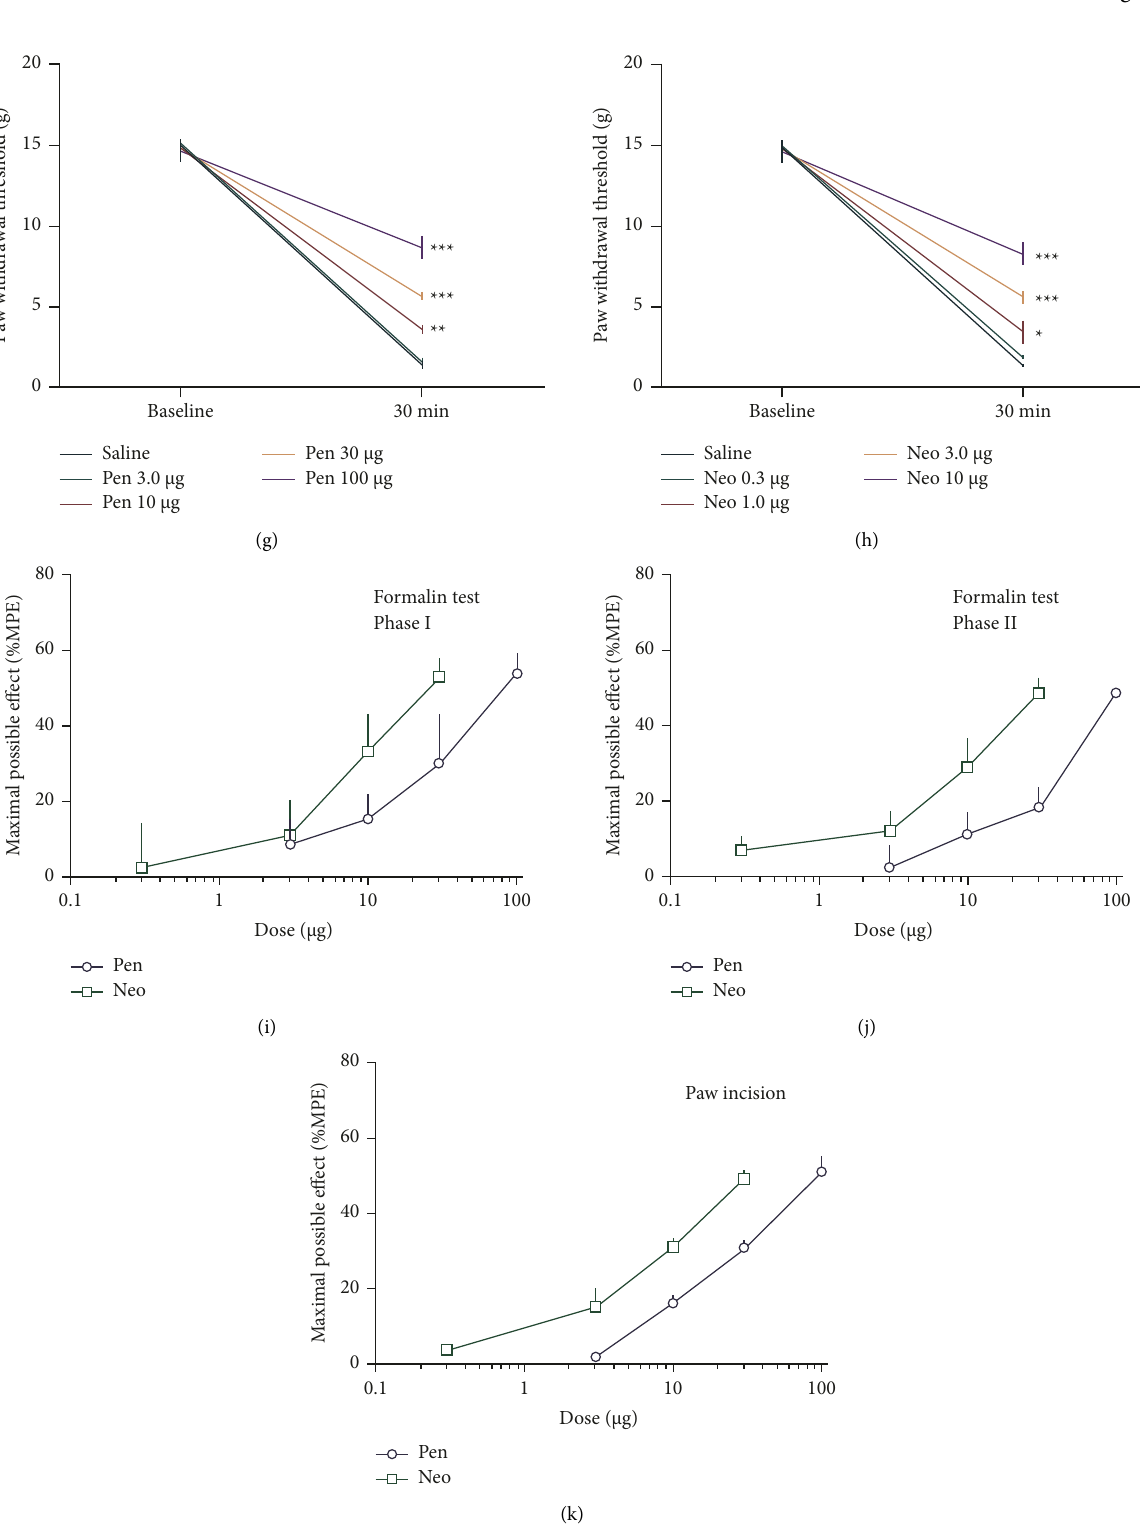
Figure 2: (a-f). Intrathecal injection of pentazocine (3–100 μ g) and neostigmine (0.3–10 μ g) induced a dose-dependent inhibition against the formalin-induced pain responses in both phases. (g-h). Injecting pentazocine or neostigmine attenuated the plantar incision-induced mechanical allodynia. (i-k). Dose-response curves of intrathecal pentazocine and neostigmine for flinching during phase I (i) and phase II (j) in the formalin test (k). Data are expressed as the maximal possible effect (% MPE). Each point on the graph represents the mean ± SEM. Compared with the saline group, ∗ P < 0 . 05, ∗∗ P < 0 . 01, ∗∗∗ P < 0 . 001, n � 10 rats in each